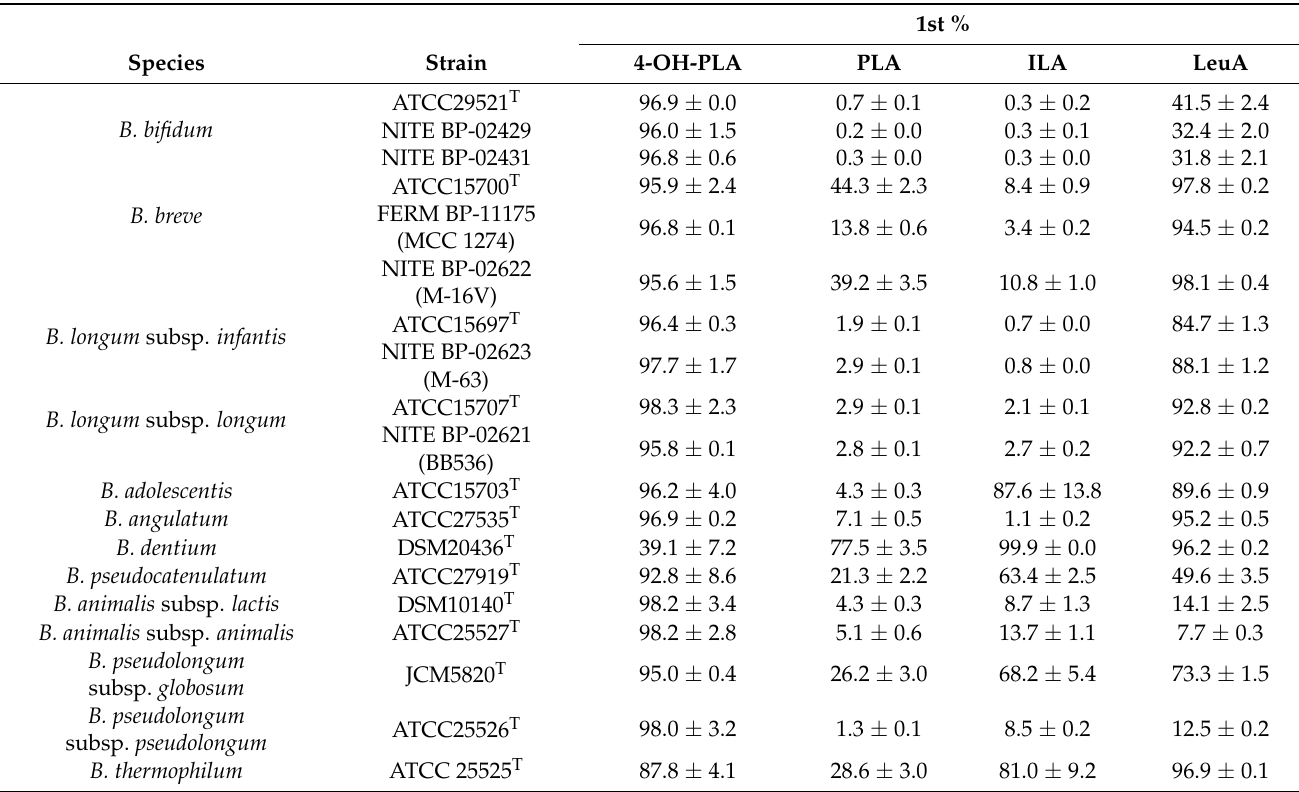
Table 2. Relative percentage of the 1st peak area of aryl-lactic acids (aryl-LAs) in the culture supernatants of Bifidobac- terium